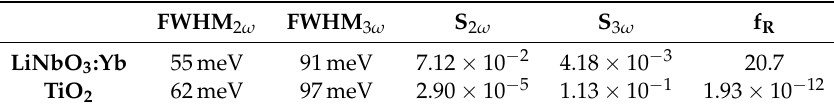
Table 1. Relevant values for the determination of the harmonic ratio f R extracted from Figure 6. FWHM is the full width at half maximum of each peak, the signal S is given by the area under the peak and the indexes 2 ω and 3 ω denote the second and third harmonic, respectively.